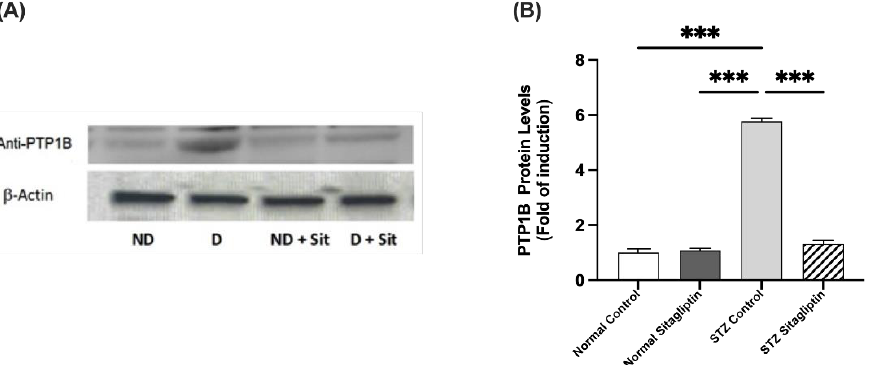
Figure 6. Effects of sitagliptin on protein tyrosine phosphatase 1B (PTP1B) expression in STZ-induced diabetic rats. ( A ) Images representing the immunoblotting of levels of proteins in the homogenates of rat kidney tissues; ND, normal control group; D, STZ-induced diabetic control group; ND + Sit, normal control group treated with sitagliptin; D + Sit, sitagliptin-treated diabetic group. Resolution of the proteins obtained from the sample tissues was performed using SDS-PAGE, and then the PTP1B antibody was used for immunoblotting, along with the β -actin antibody subsequent to stripping. ( B ) ImageJ software was used to quantify the immunoblot band densities. β -Actin was utilized to normalize the levels of PTP1B protein. The expression of quantities is indicated as fold induction relative to the group comprising normal controls. Data denote the mean ± SEM ( n = 6 samples from six animals per group). The one-way ANOVA test and then the Bonferroni post hoc test were used to compare groups; *** p < 0.001.